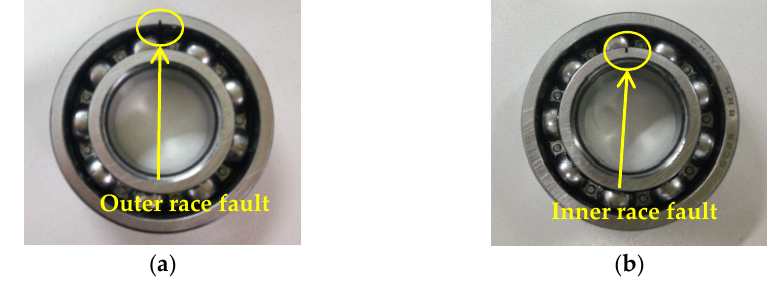
Figure 23. ( a ) Outer race fault bearing; ( b ) inner race fault bearing. Table 6. Size parameters of testing bearing in case 3. Bearing Type